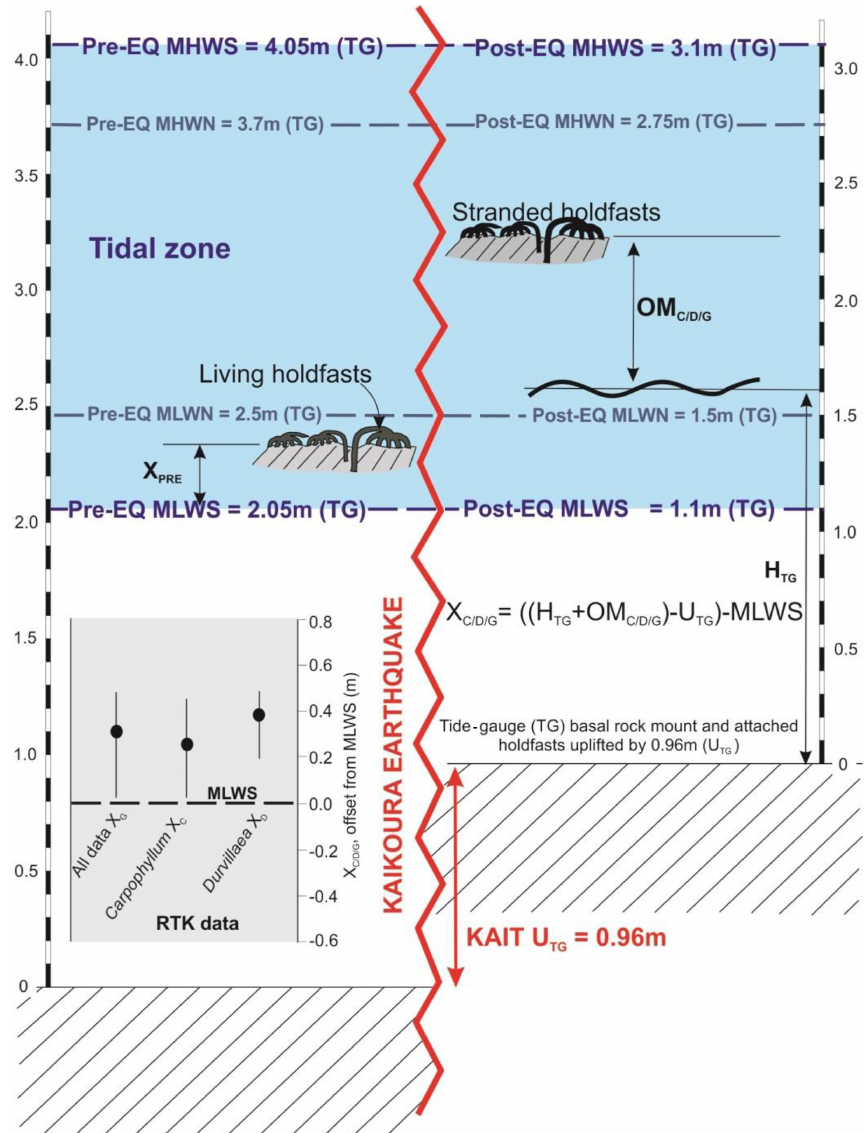
Figure 3. Schematic diagram illustrating uplift and stranding of holdfasts at the Kaik¯oura tide gauge. It also schematically illustrates the method for calculating uplift from the upper limit of holdfasts ( X C / D / G ; Eq. 1) using mean low-water spring (MLWS) values within the tide- gauge data. MLWN: mean low-water neap, MHWN: mean high-water neap, MHWS: mean high-water spring, H TG : tide height as measured at the tide gauge, U TG : uplift as measured by tide-gauge offset data pre- and post-deformation, OM: observed measurement (holdfast), X : offset of holdfasts from MLWS. Inset: results for X as calculated for kelp at the Kaik¯oura tide gauge. Mean values are shown by a solid circle, while tails represent maxima and minima values. See Sect. 3.2.1 for